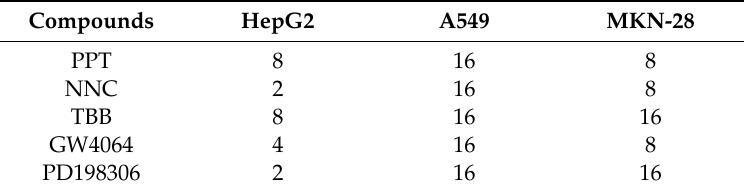
Table 5. Eukaryotic cell cytotoxicity of compounds ( µ g / mL). Table 6. Fractional Inhibitory Concentration (FIC) Index of test compounds with selected antibiotics